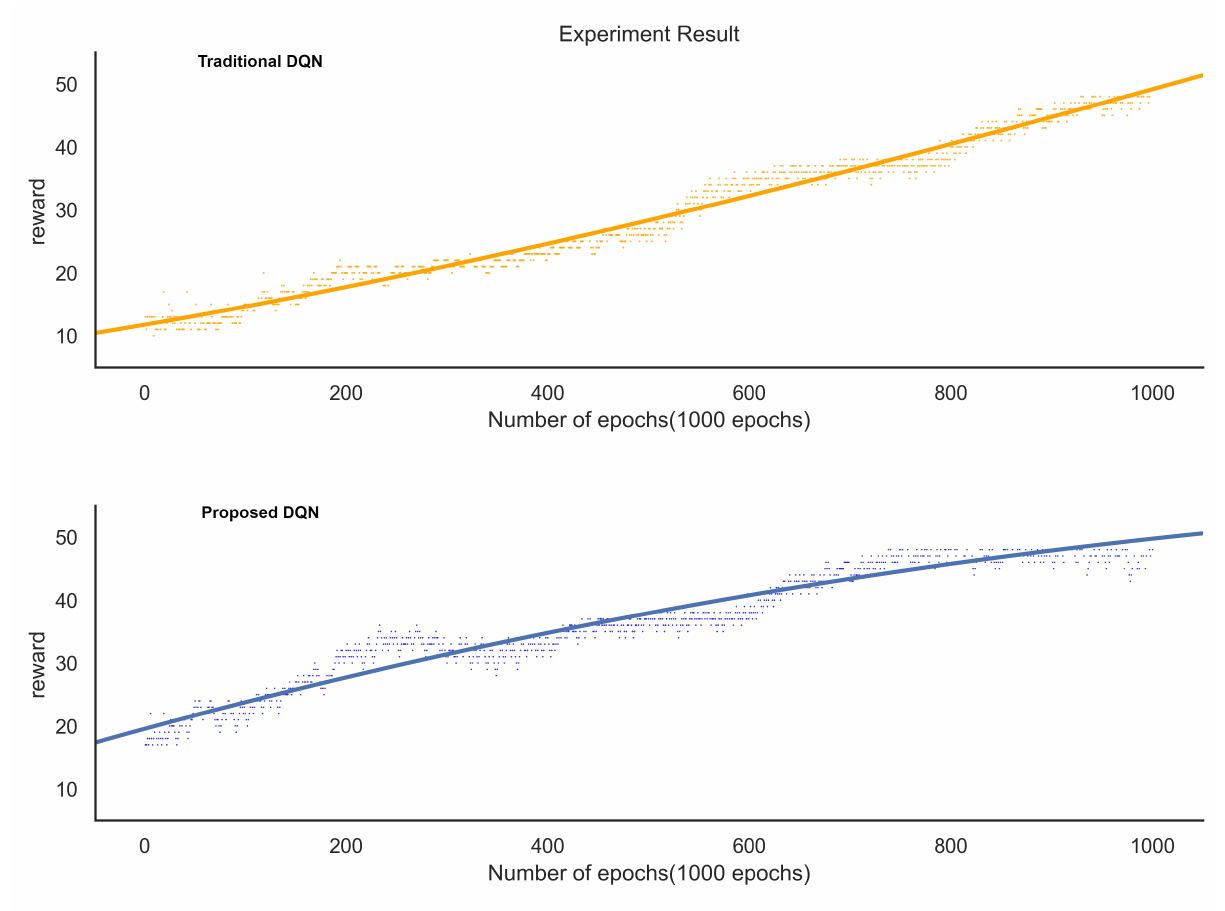
Figure 9. Comparison of the proposed method and the regression line of the conventional DQN.